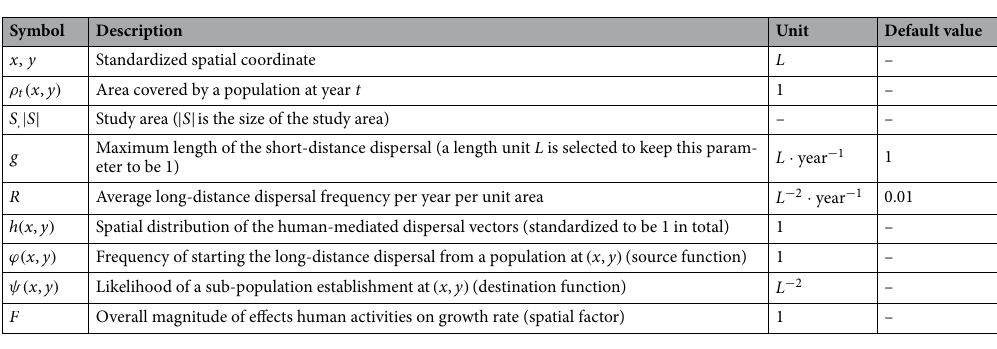
Table 1. Symbols and their default